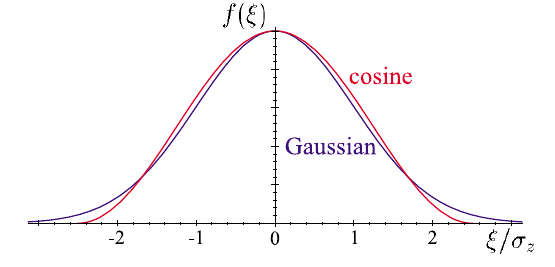
FIG. 3. (Color) Cosine and Gaussian distributions.